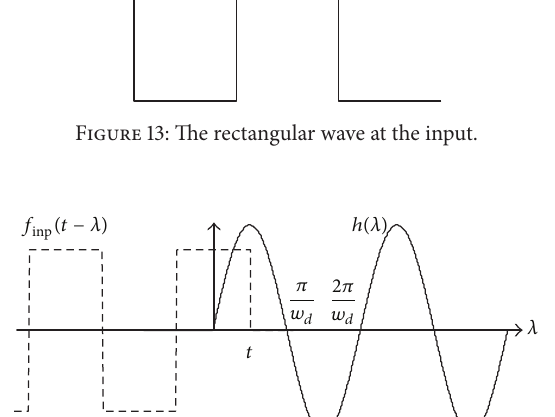
Figure 14: Convolution with a rectangular wave at the input. Compare to Figures 9 and 10.